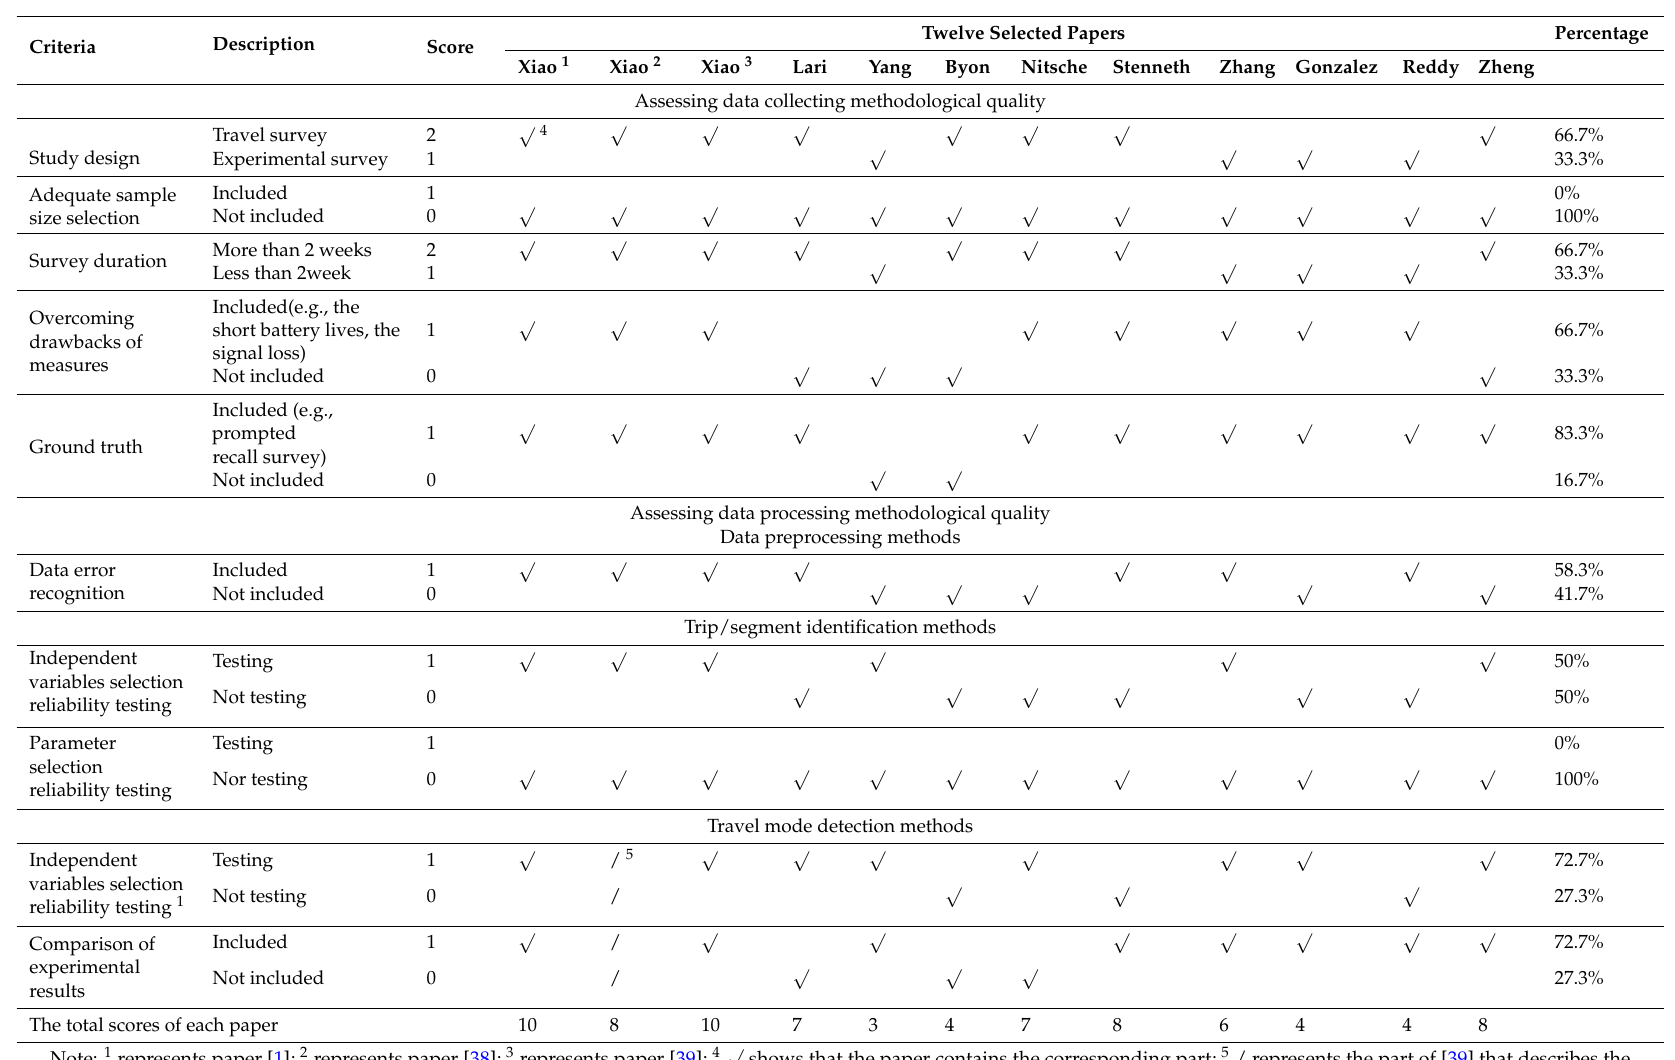
Table 6. Distribution of quality characteristics across reviewed